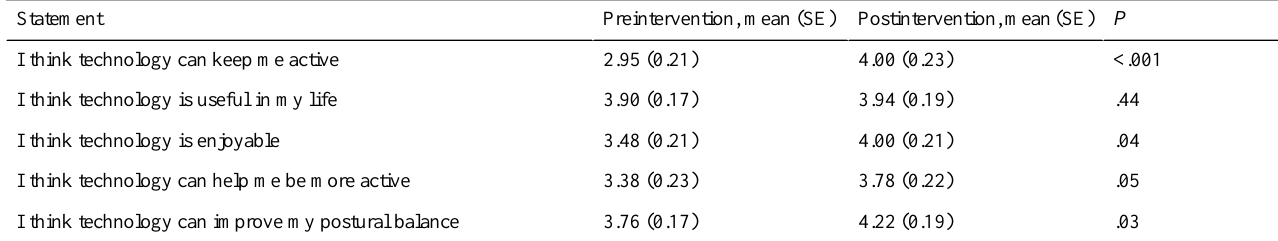
Table 1. Survey responses pre- and postintervention (N=24). a